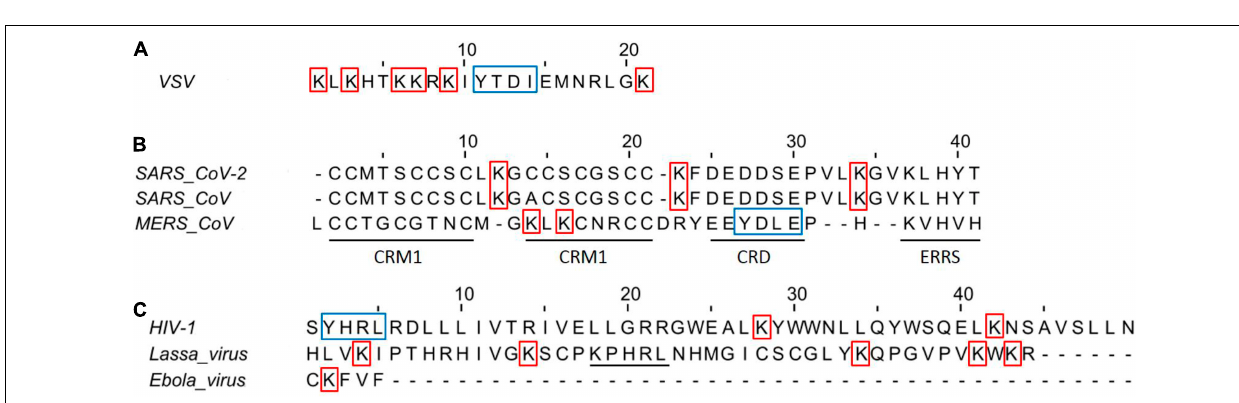
FIGURE 3 | Amino acid sequences of viral glycoproteins class I CT domains. (A) Vesicular stomatitis virus CT domain Indian strain. (B) Amino acid sequence alignment of CoVs Spike protein in the CT domains. CRM, cysteine-rich motif; CRD, charge-rich domain; ERRS, endoplasmatic reticulum retrieval signal (KxHxx). The amino acid alignment was performed with the Jalview v2.11.1.4 using CLUSTAL W. (C) Amino acid of HIV, Lassa, and Ebola virus glycoproteins CT domains. Underline in Lassa virus indicates the ERRS motif. The HIV CT domain was trimmed to 60 and 40 amino acids in the N and C terminal, respectively. The red squares indicate Lys that could be implicated in efficient infectivity, while the blue squares indicate the tyrosine-dependent internalization signals (Yxx (cid:56) motif, where (cid:56) is F, I, L, M, or